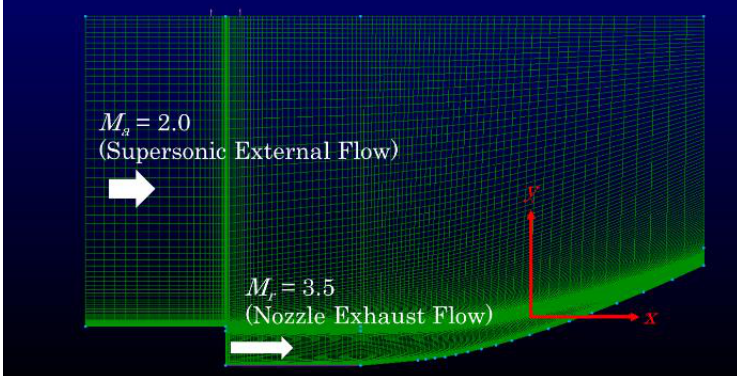
Figure 4. Mesh grids used for calculation of the aerospike nozzle flowfield. The flow direction is from left to right. The region of interest for computation is the area indicated by the grid.